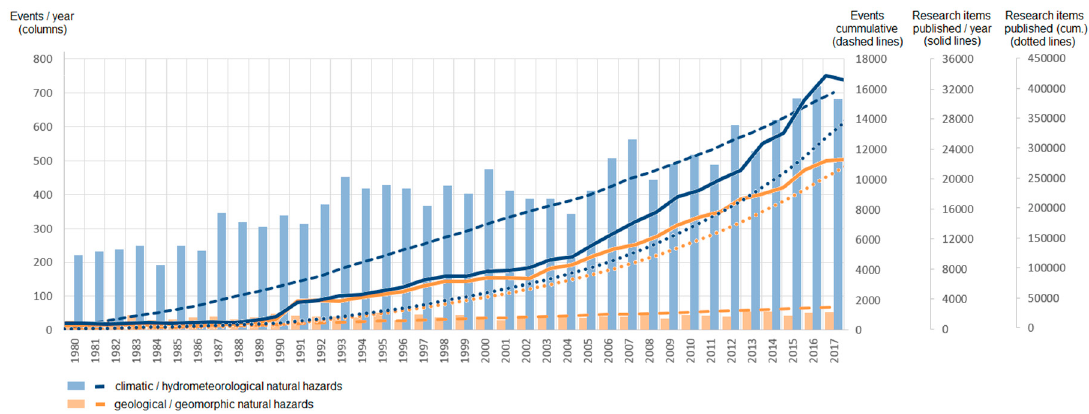
Figure 5. Research on natural hazards and the occurrence of natural hazards in 1980–2017 (number of events based on [1]).